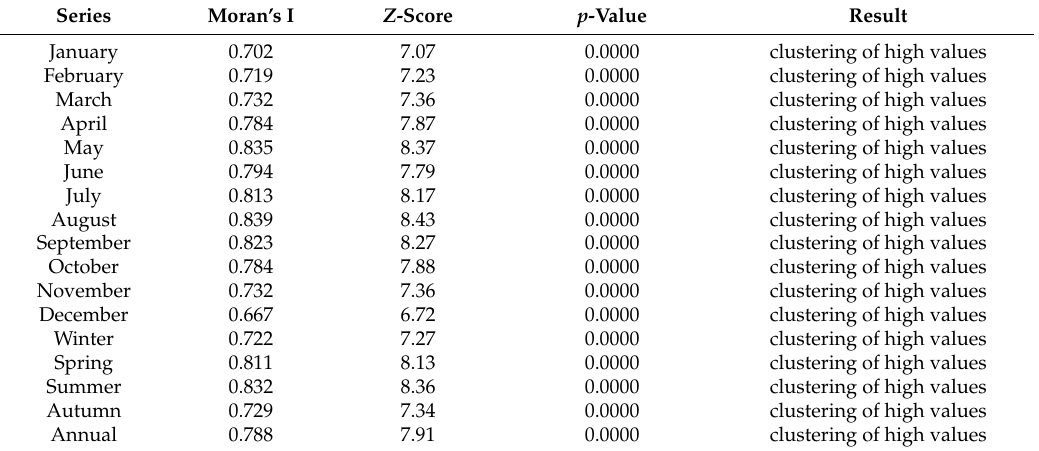
Table 10. Moran’s I autocorrelation statistics in